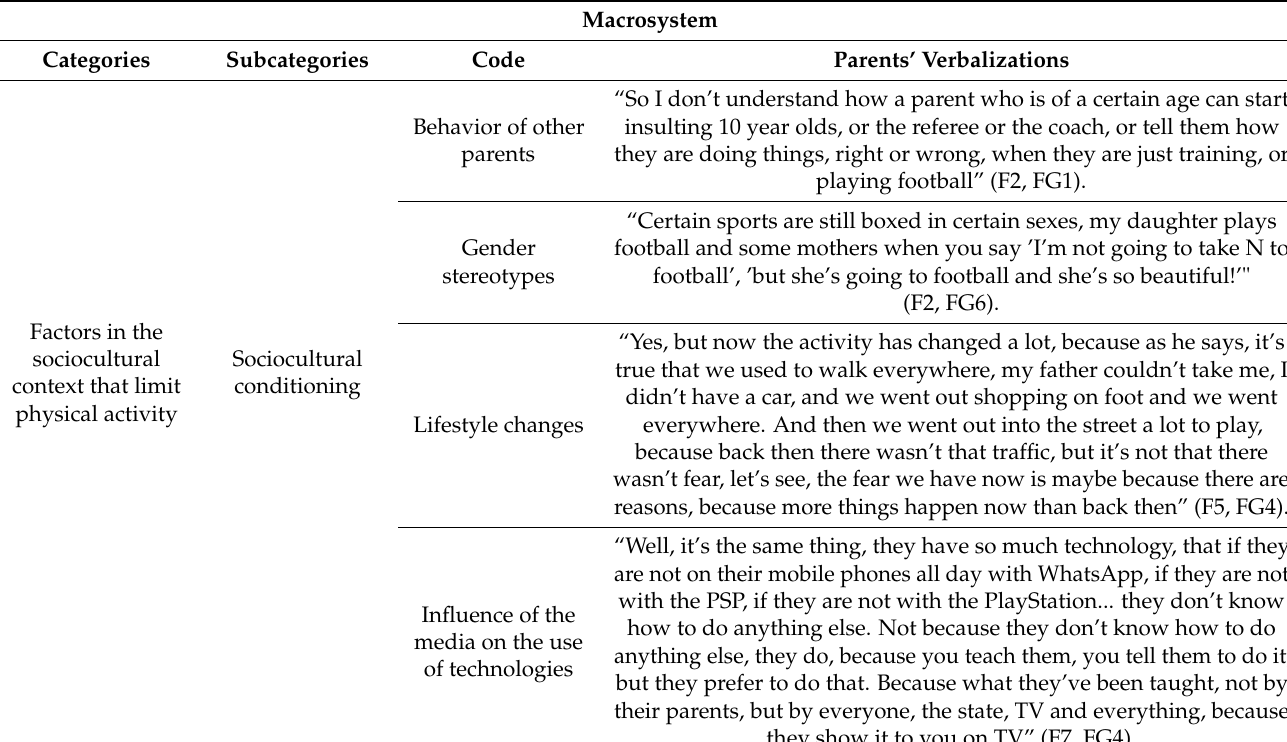
Table 7. Macrosystem barriers to physical activity for